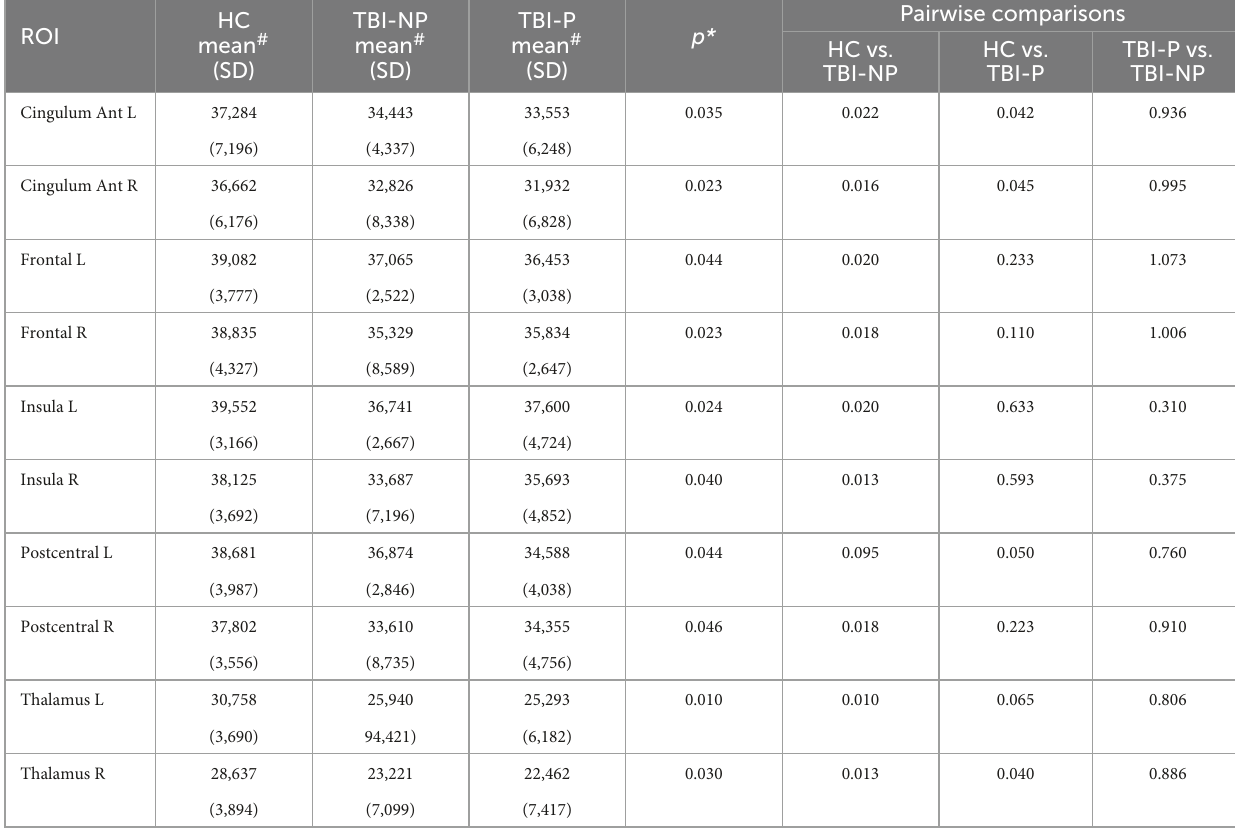
TABLE 3 Results from analysis of covariance (ANCOVA) controlling for age between HC ( N = 31), TBI-NP ( N = 17) and TBI-P ( N = 16) groups for N -acetylaspartate (NAA).